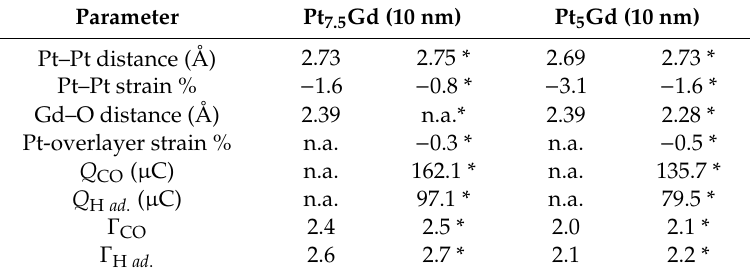
* after electrochemical cycling until stable CVs